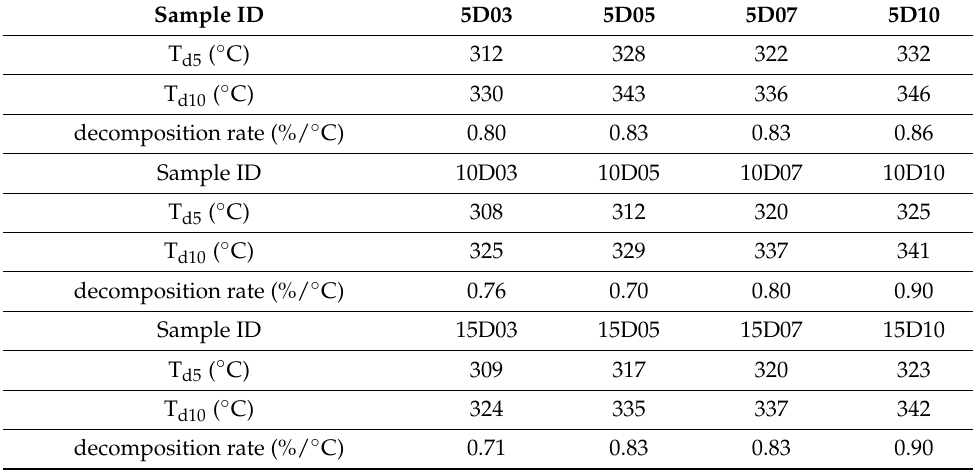
Table 5. Pyrolysis temperature property data of